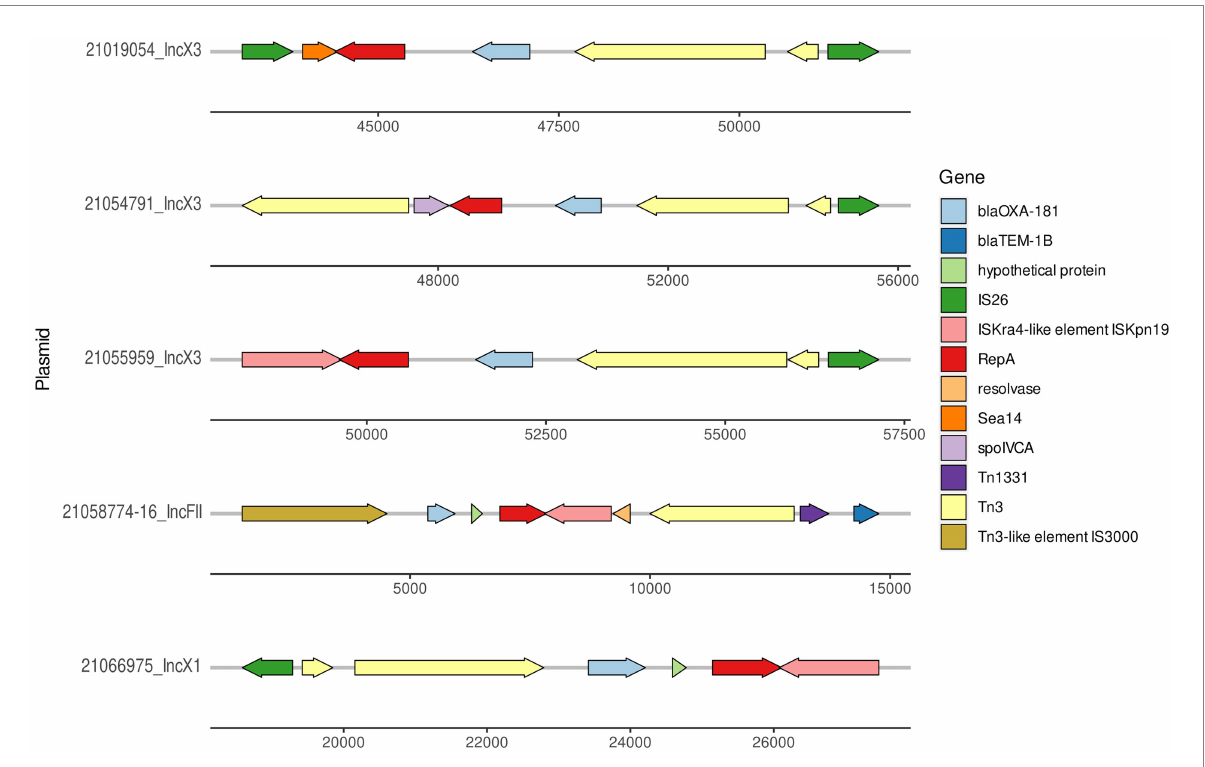
FIGURE 2 Graphical representation of the region where bla OXA-181 was located in the three IncX3 plasmids, one representative IncX1 (pMOL6975) from ID21066975 (accession number ERS12413440) and IncFII (21058774–16)